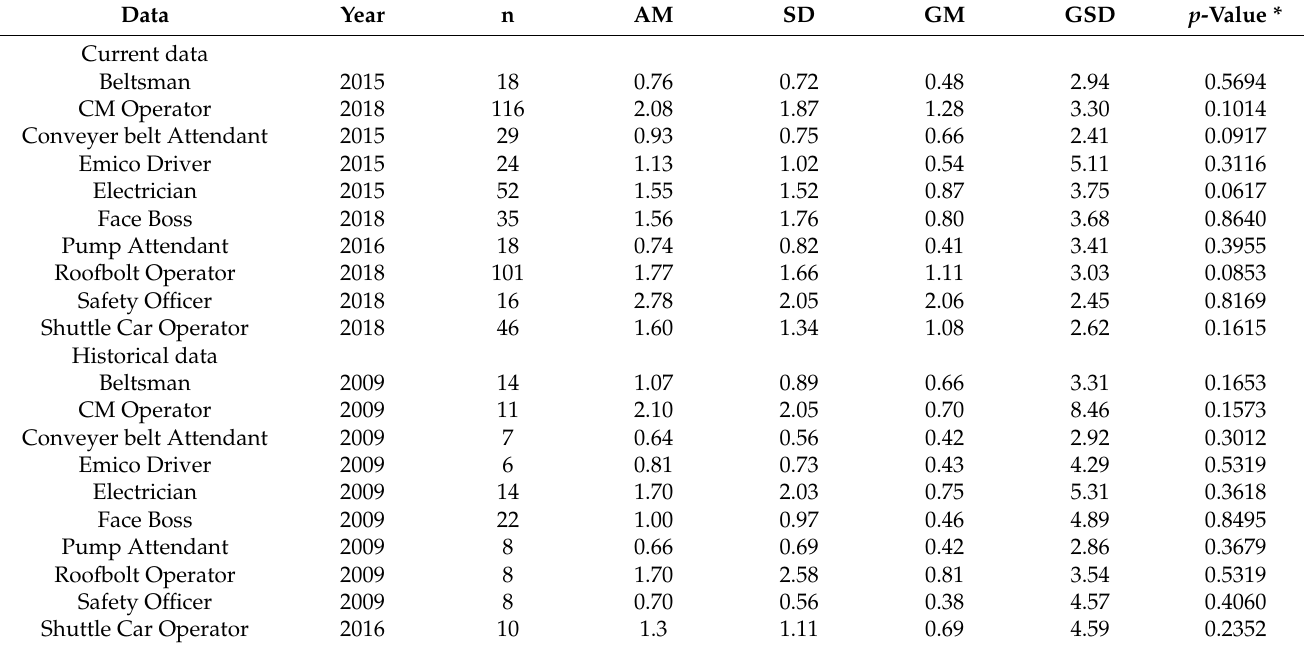
Table 1. Summary of coal dust exposure concentration (TWA8h) in mg/m 3 for the current monitoring data and their corresponding historical past data, and comparison of the median exposure across